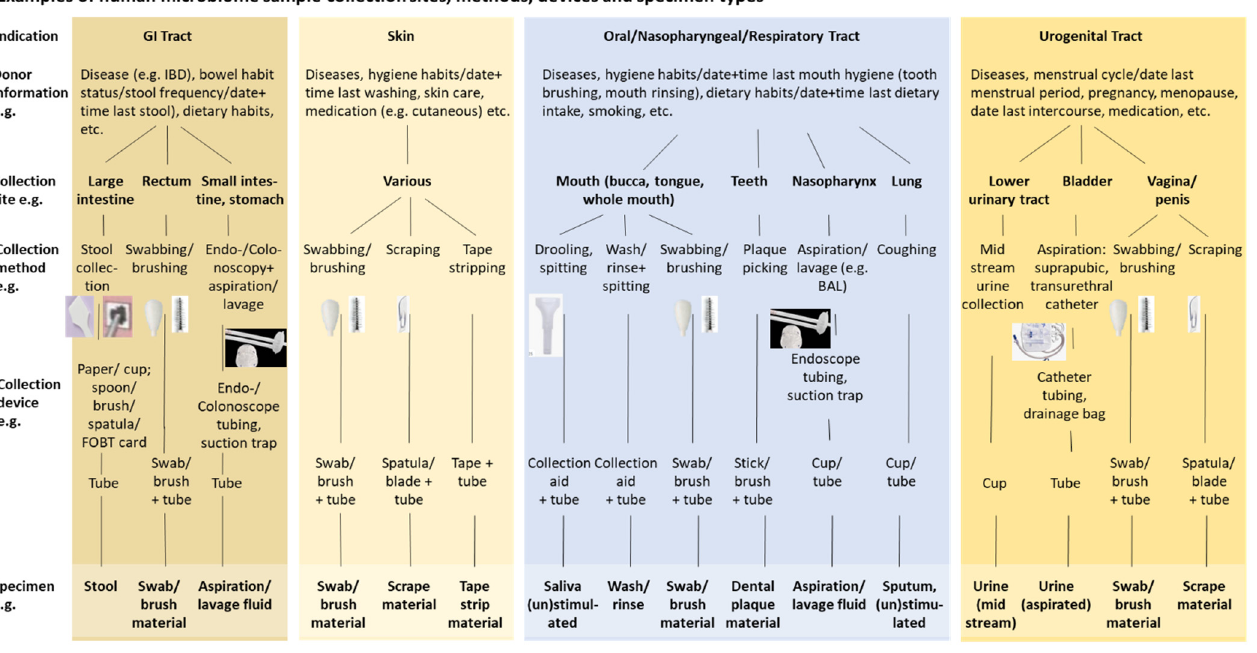
Figure 1. Examples of human microbiome sample types from different collection sites using different collection methods and devices. GI tract, skin, oral/nasopharyngeal/respiratory tract, and urogenital tract are major categories of anatomical sites from which samples for different indications and intended molecular examinations/analyses are collected in human diagnostics and R&D. This is associated with different pre-analytical variables, which include the patient/specimen donor, the exact topographical collection site in/on the body, and the collection method for which various collection devices exist, which finally leads to different types of human samples. CEN/TS 17626:2021 considers this and also reflects it in its structure.